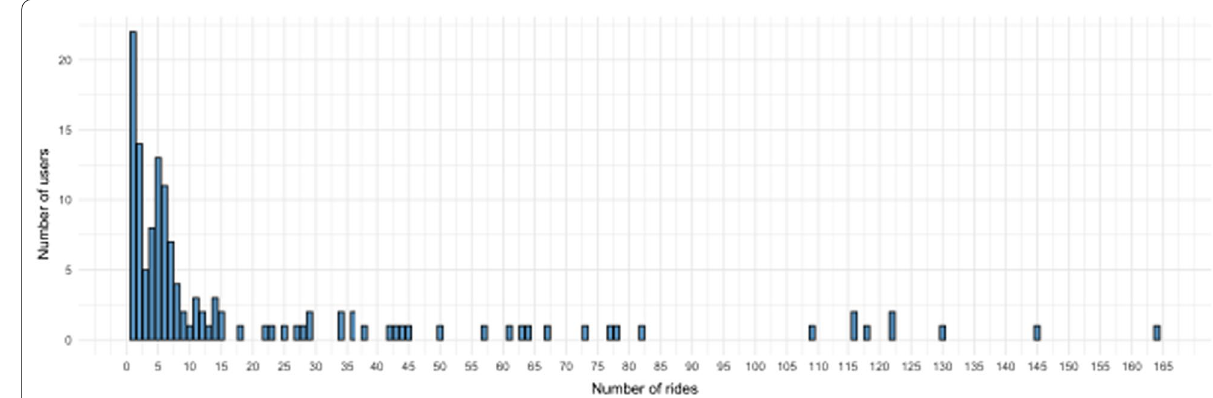
Fig. 3 Distribution of the number of rides taken by Kussbus users